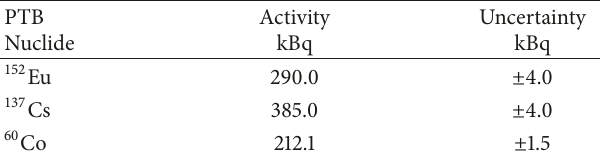
Table 1: PTB radioactive sources activities and their